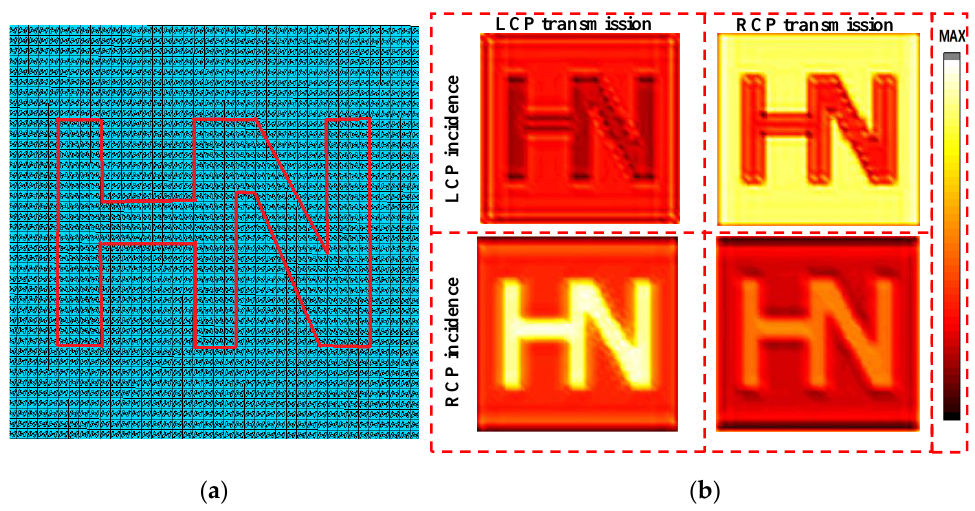
Figure 7. ( a ) The configuration of HN letters. ( b ) Cross-polarization and co-polarization images under LCP and RCP incidence. The detection probe is located at 200 μm from the array surface. The relationship between the rotation angle of the metasurface unit and the phase is calculated, as shown in Figure 8a. Based on the RS diffraction formula, the holographic plate is designed for the desired image. Hologram and holographic plate phase distributions at different imaging distances are shown in Figure 8b.